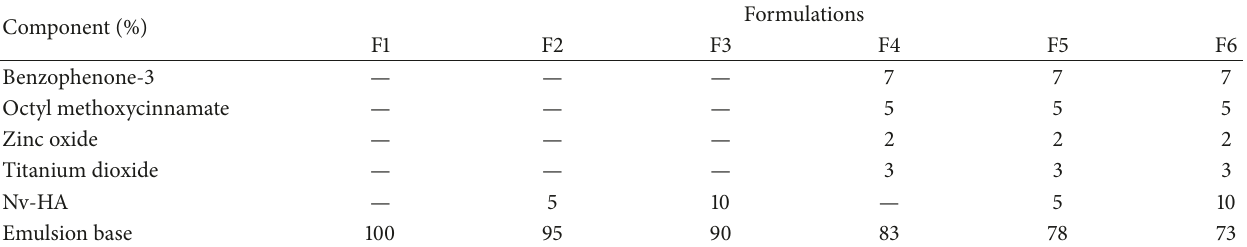
Table 2: Photoprotective formulations containing synthetic filters and/or Nv-HA in different percentages. Component (%)